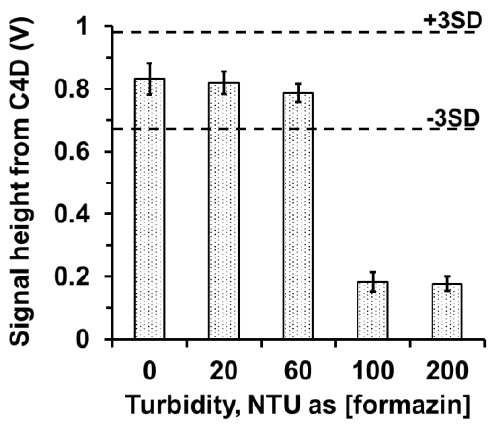
Figure 5. Tolerance limit of the developed system for turbidity on the standard solution of 25 mg L − 1 SO 32 − (the tolerance limits of +/ –